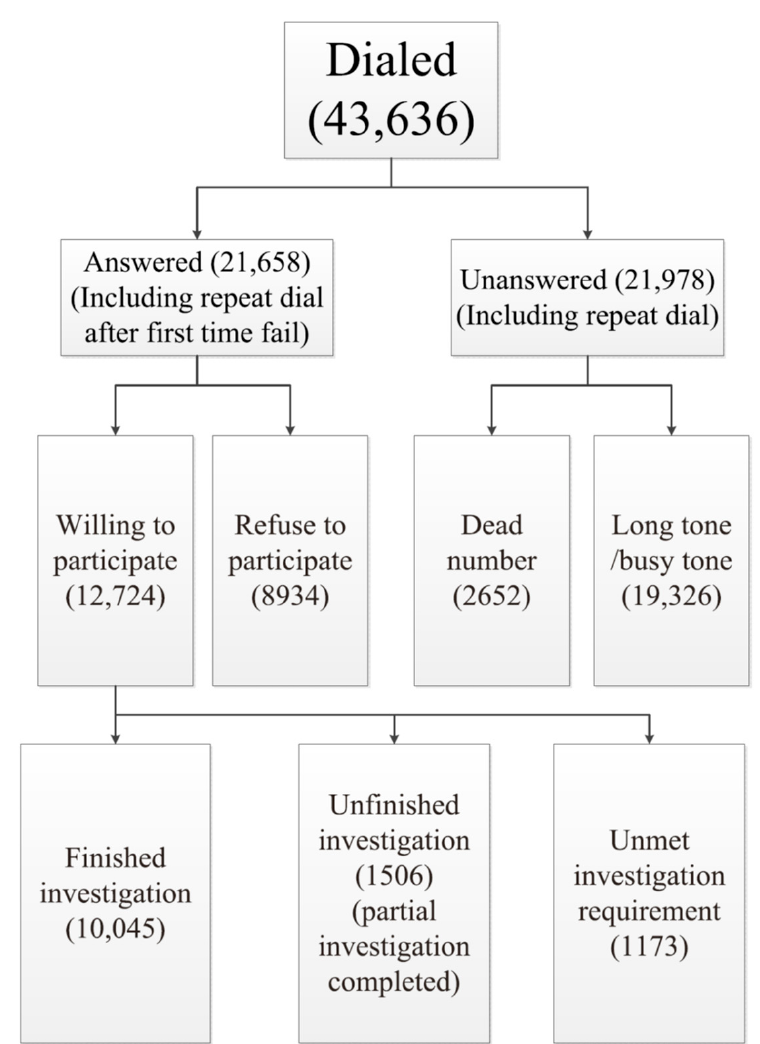
Figure 2. Flowchart of influenza-like illness reported in a telephone survey in six provinces of China, 2017/2018.